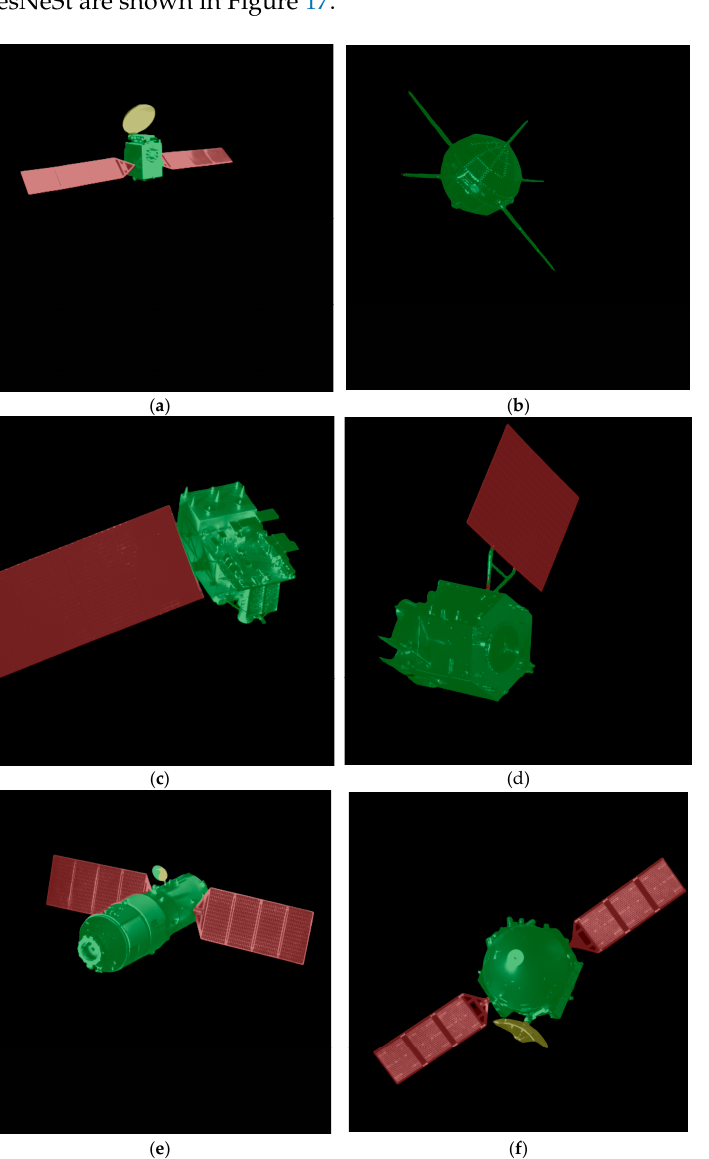
Figure 17. Semantic segmentation results of real-shot validation dataset using Deeplabv3p ResNeSt: ( a ) Beidou; ( b ) DFH; ( c ) FY-3; ( d ) FY-4; € TG; ( f ) TW.